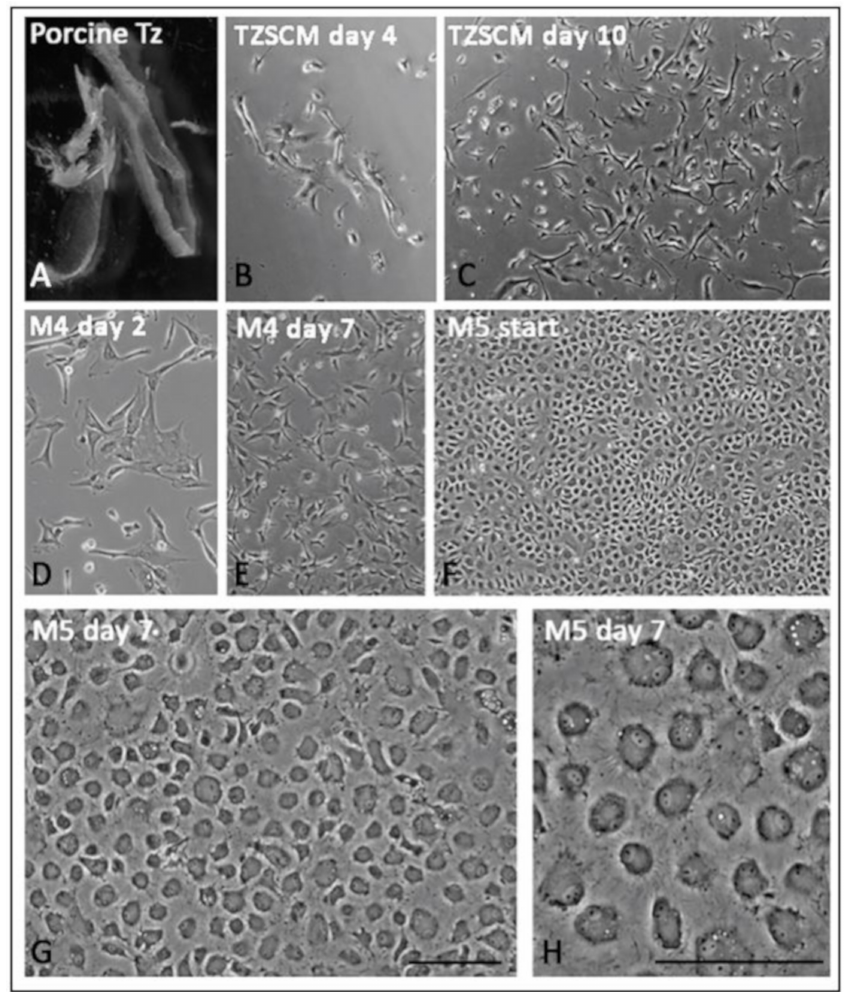
Figure 8. Primary culture of porcine transition zone (TZ) cells. ( A ) Dissected TZ tissue with minimal TM and PE. ( B , C ) Primary TZ cells in culture with TZ stem cell medium (TZSCM) for 4 and 10 days, respectively. ( D–F ) Primary TZ cells in proliferative M4 medium at day 2, 7 and 14 for monolayer formation. ( G,H ) Cells in endothelial stabilizing M5 medium for 7 days. A homogenous monolayer of tightly-packed polygonal to hexagonal-like cells was generated. Scale bars: 50 µ m. By immunostaining, the confluent cells under M5 stabilization expressed ZO1 on cell membrane + + and Na K ATPase in both cytoplasm and cell surface while the proliferating cells in M4 culture did not (Figure 9A). On the other hand, the nuclear Pitx2 was more synthesized in proliferating cells than the stabilized cells. Western blotting illustrated that ZO1 (195 kDa) and Na (105 kDa) were detected in M5 stabilized cells, while Prdx6 (25 kDa) remained unchanged (Figure 9B). Band densitometry results showed the induction of ZO1 by around 4-folds and Na 7–12 folds in confluent cells. The CEC marker induction was replicated in two M5 culture time points (day 7 and